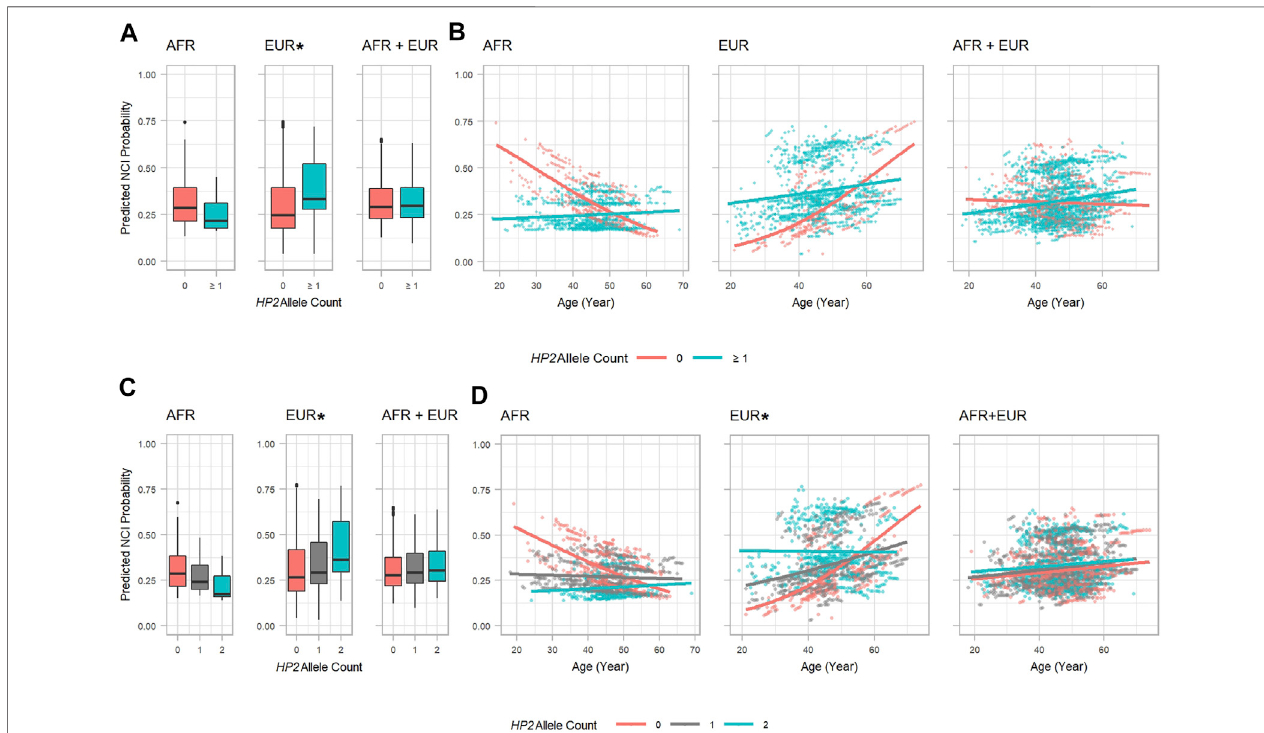
FIGURE2| HP2 DominantEffect onPredicted NCI Probability intheAFR and EURParticipants. (A,C) :Boxplots showingthemain effect of HP2 on predicted NCI probabilities. (B, D) : Scatter plots with trendlines showing the effect of age on predicted NCI probabilities. Probabilities in (A, B) are from models shown in Table 3 . Probabilities in (C, D) are from models shown in Table 4 . Plots are colored by HP2 status. Additional adjustment of the fi rst 3 PCs was used in the AFR + EUR analysis. “ p ” indicates statistical signi fi cance.